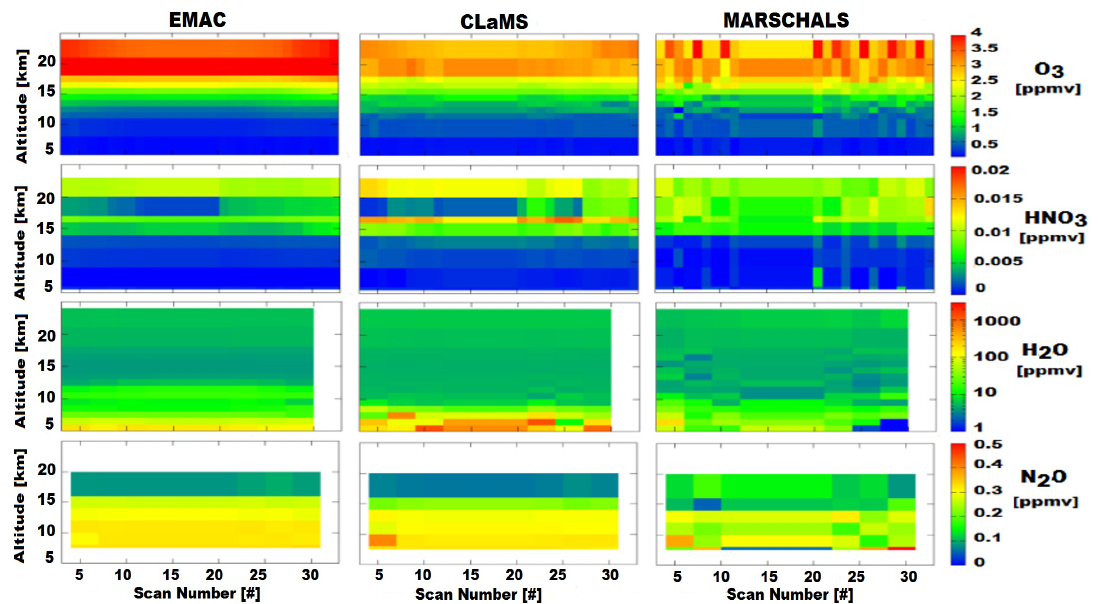
Figure 2: From Top to bottom: EMAC (left) and CLaMS (center) results after convolution with MARSCHALS AK and MARSCHALS retrieved VMRs (right) for O 3 , HNO 3, H 2 O and N 2 O. above (or below) the highest (or the lowest) MARSCHALS tangent point, we used the time, latitude and longitude values of the highest (or of the lowest) MARSCHALS tangent